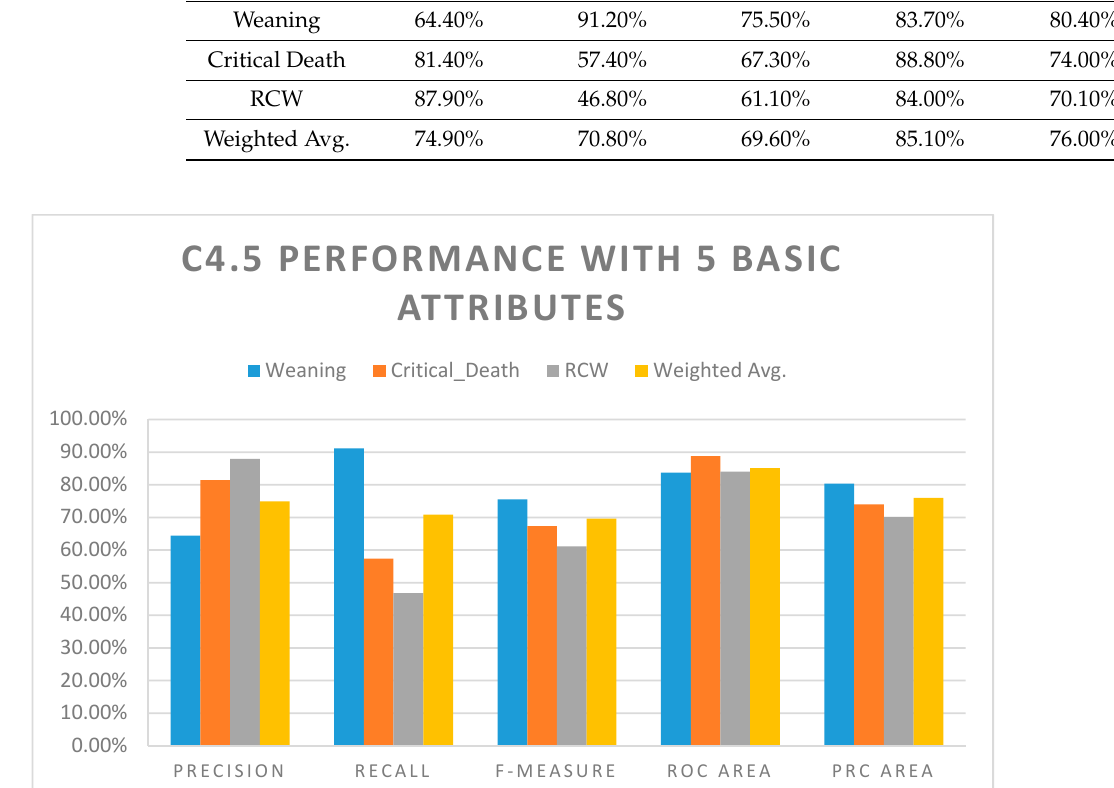
Table 5. C4.5 algorithm performance for Model II with 5 basic and 12 disease attributes.